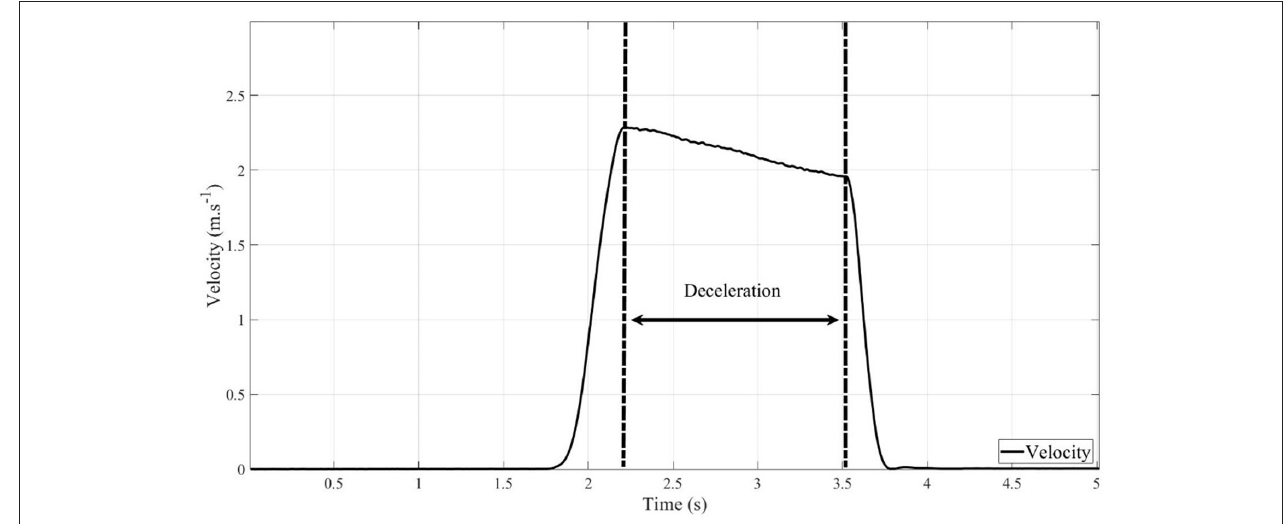
FIGURE 3 | Deceleration on the velocity